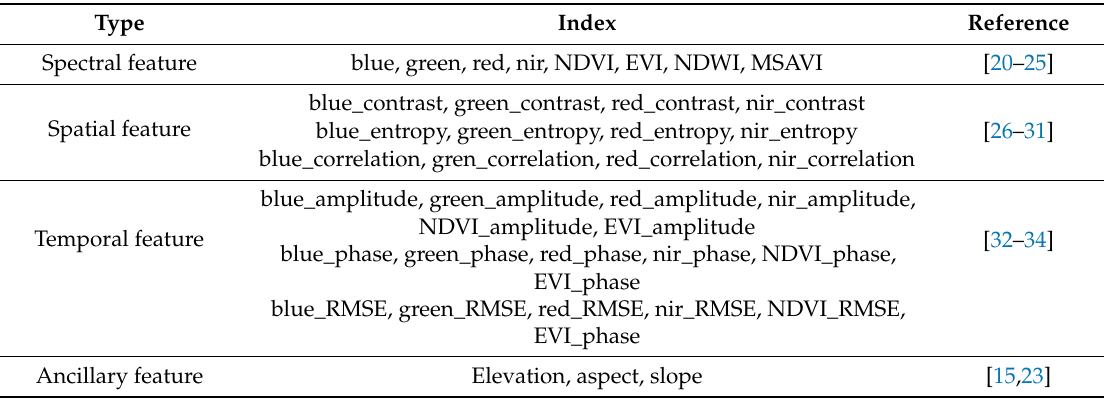
Table 2. List of features for forest type